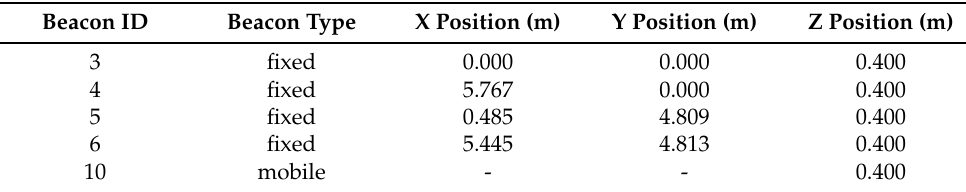
Table 3. Map coordinates of the IPS beacons used for 2D localization. Beacon ID Beacon Type